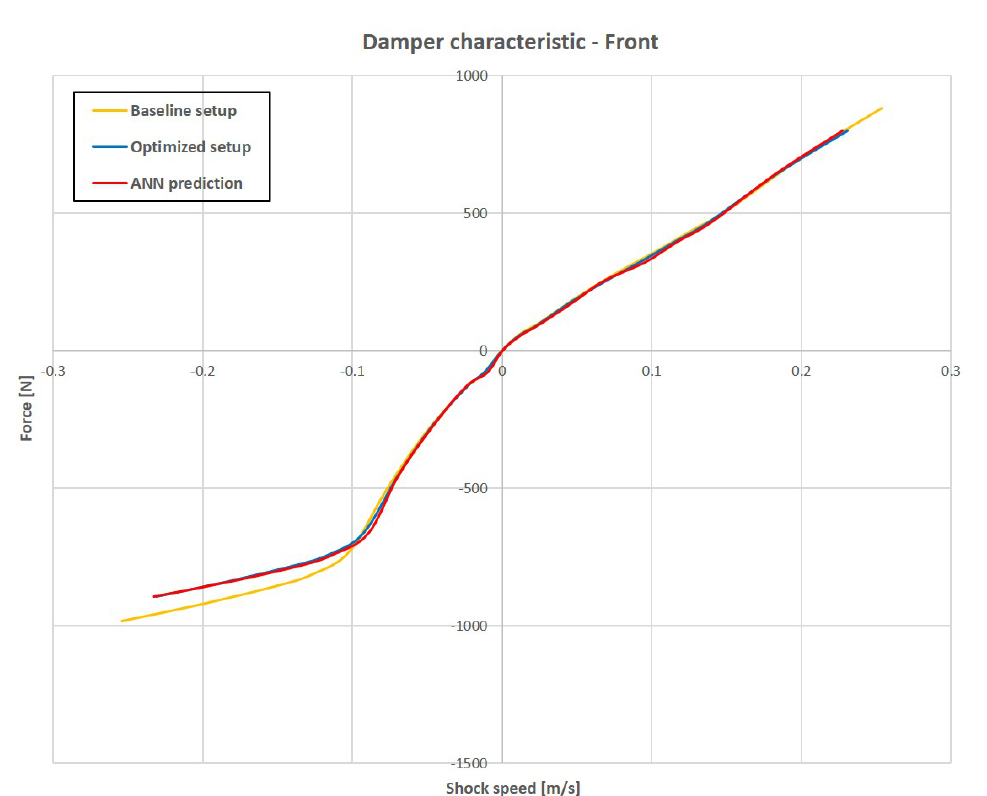
Figure 33. Front damper characteristic